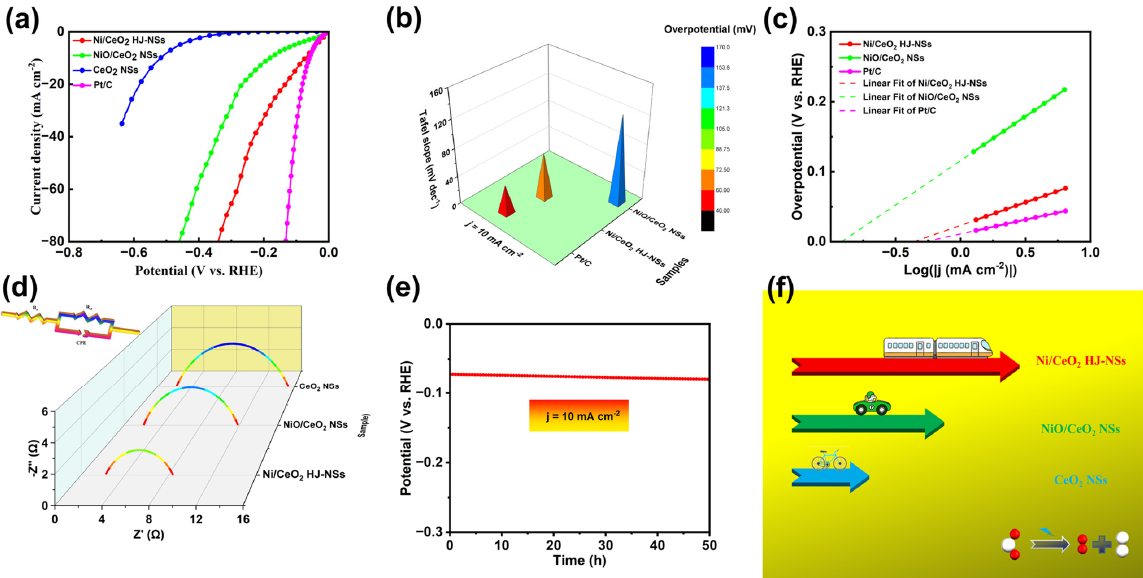
Figure 4. Electrochemical characterization of HER properties of Ni/CeO 2 HJ ‐ NSs in 1.0 M KOH so ‐ lution. ( a ) LSV polarization curves, ( b ) Tafel slopes and overpotentials required to achieve 10 mA cm − 2 of various catalysts. ( c ) Exchange current density curves. ( d ) EIS Nyquist plots. ( e ) Chronopo ‐ tentiometric curve of Ni/CeO 2 HJ ‐ NSs. ( f ) Comparison of electrochemical performance of the pre ‐ pared catalysts.